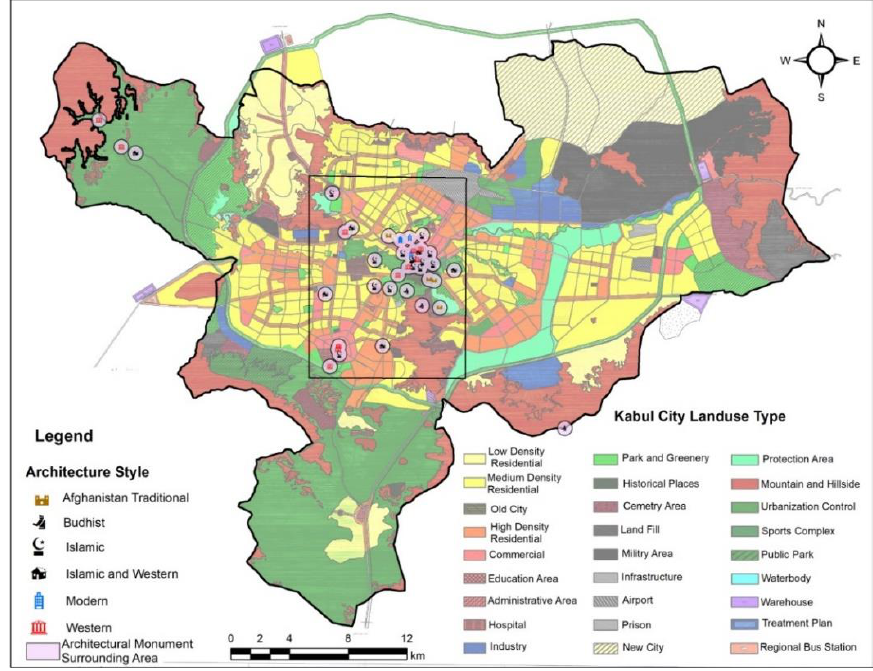
Figure 17 Distribution of historical monuments in Kabul city Modified from (KM,